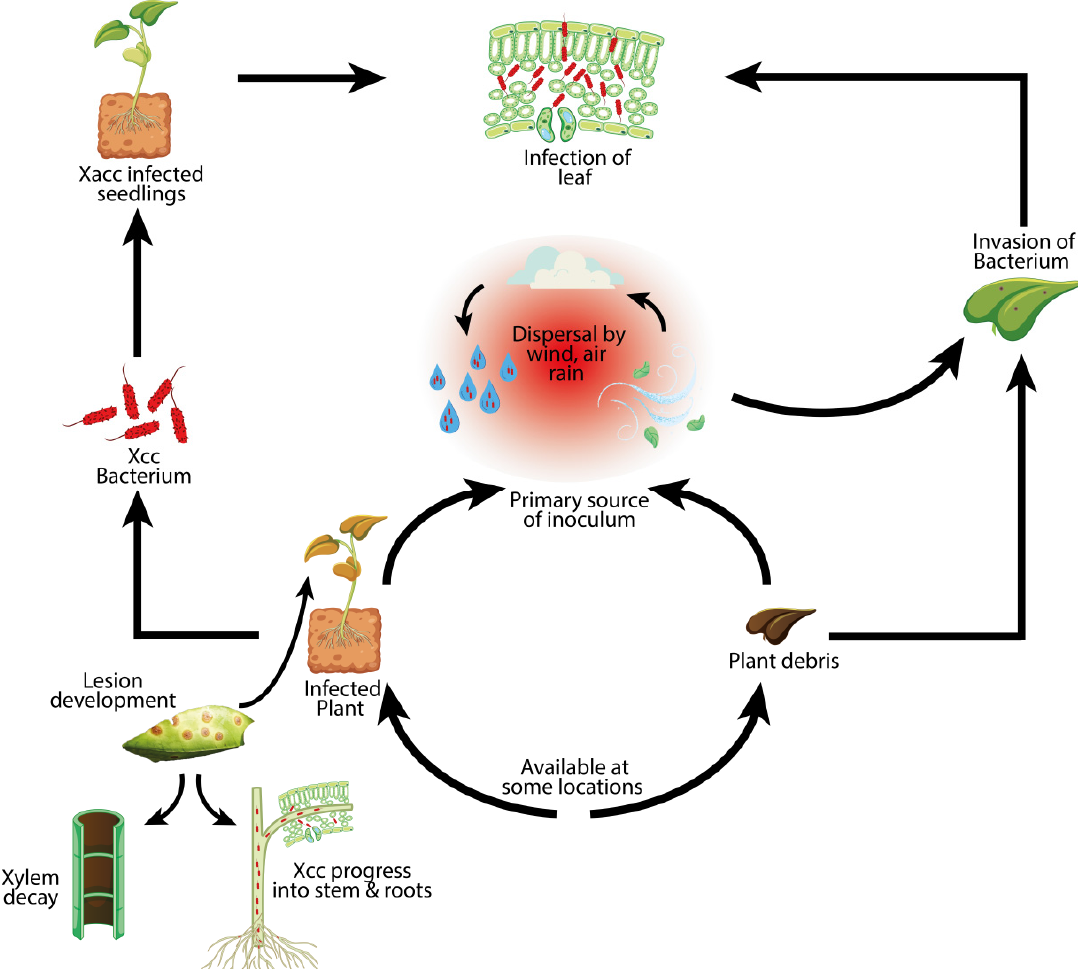
Figure 3. Xanthomonas citri subsp. citri is spread by wind-blown rain and can infect all above-ground parts of the plant. The infection starts as small, water-soaked lesions which enlarge and become covered with yellow-brown bacterial exudate. The lesions eventually kill the tissue, causing defoliation and fruit drop. The disease can severely reduce yield and fruit quality, can kill trees if left unchecked, and the bacteria are able to survive on the dead tree for a period of time.